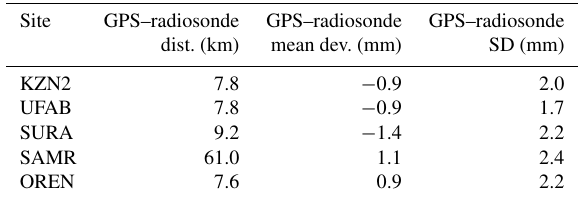
Table 2. GPS–radiosonde